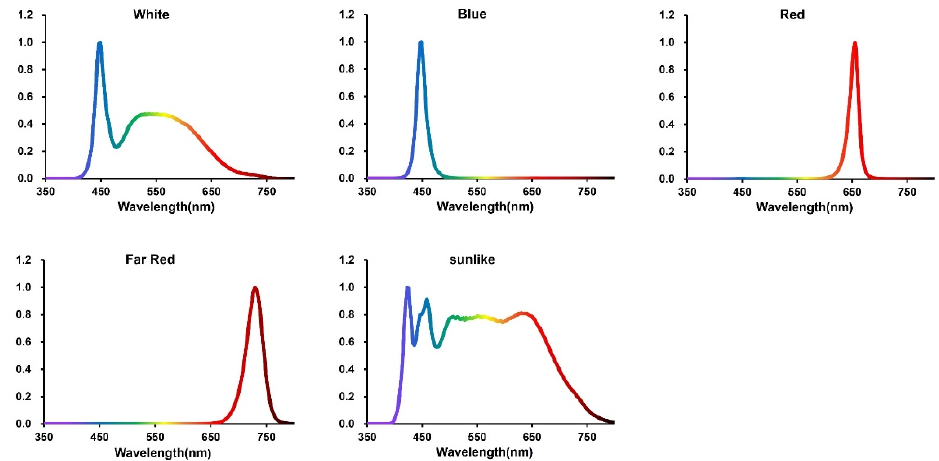
Figure 1. Spectral maps of the five light treatments of the experiment.